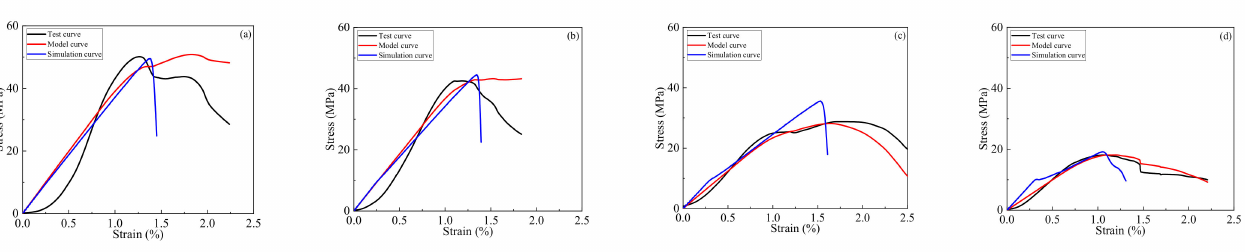
Figure 10. Comparison of the test, model, and simulation curves: ( a ) RBCM-10; ( b ) RBCM-20; ( c ) RBCM-30; ( d )